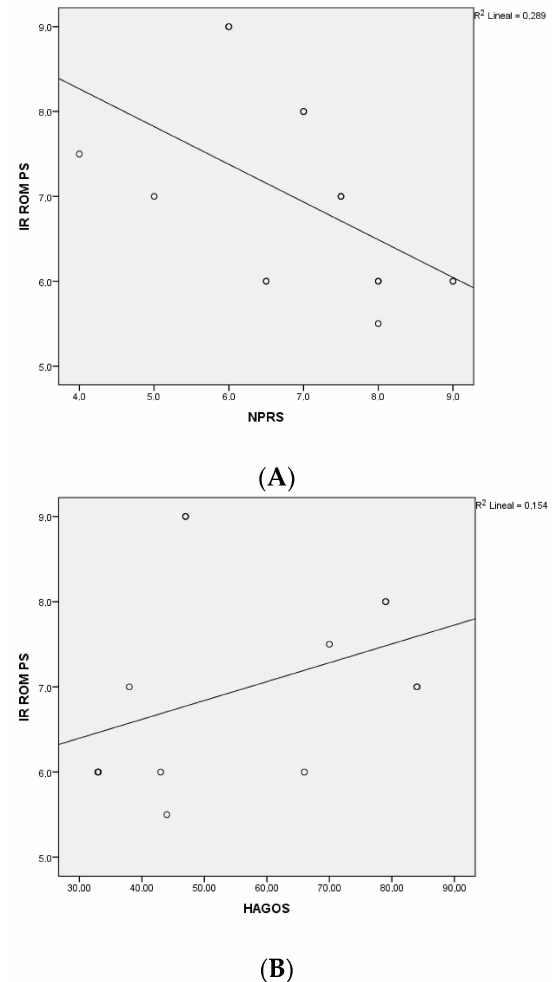
Figure 2. ( A ). Correlation analysis between IR ROM and pain intensity. ( B ). Correlation analysis between IR ROM and physical